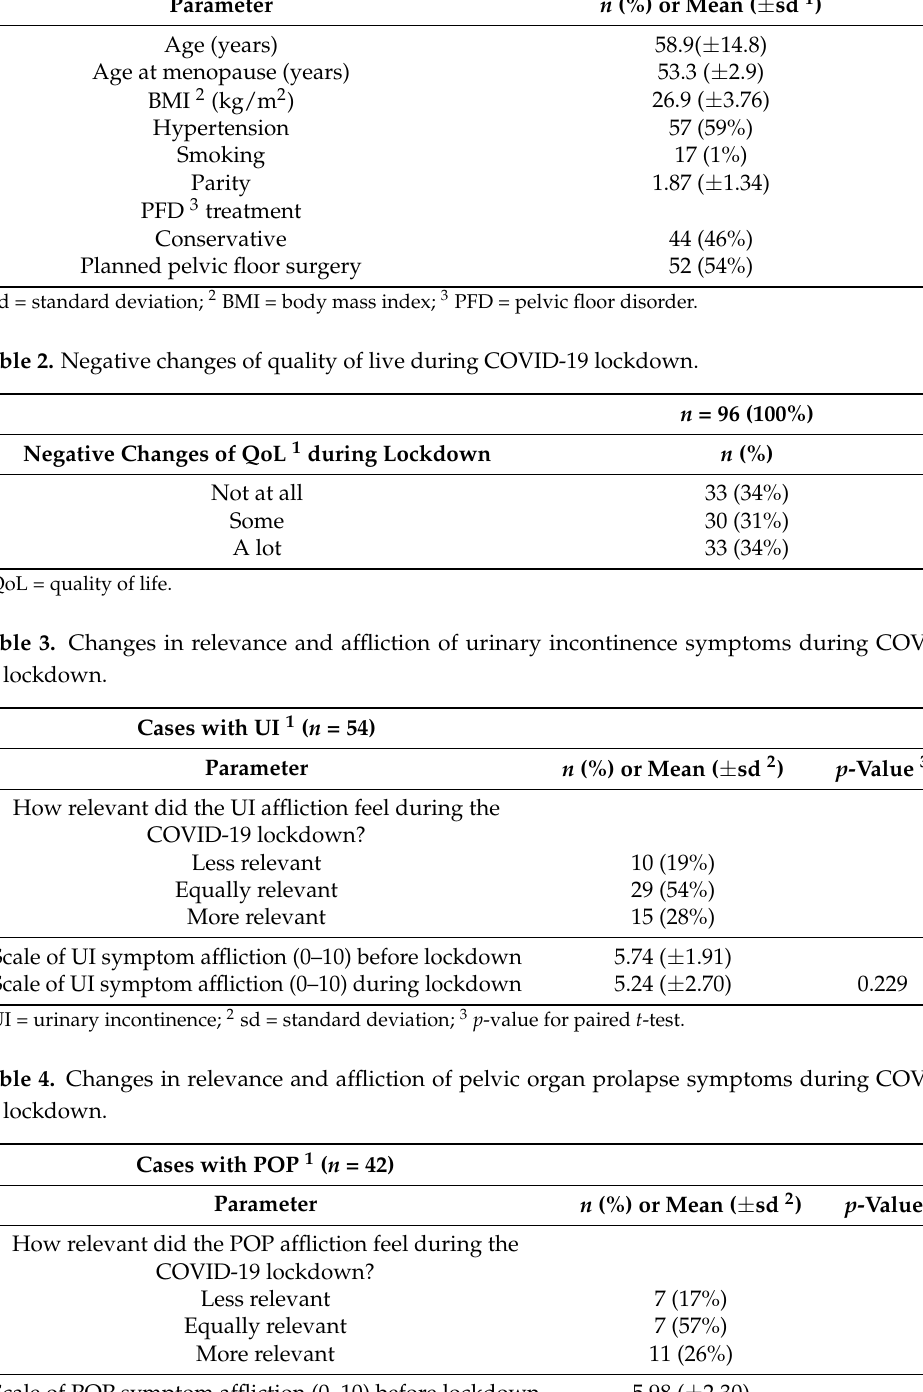
Table 1. Patients characteristics of interviewed women with pelvic floor dysfunctions.